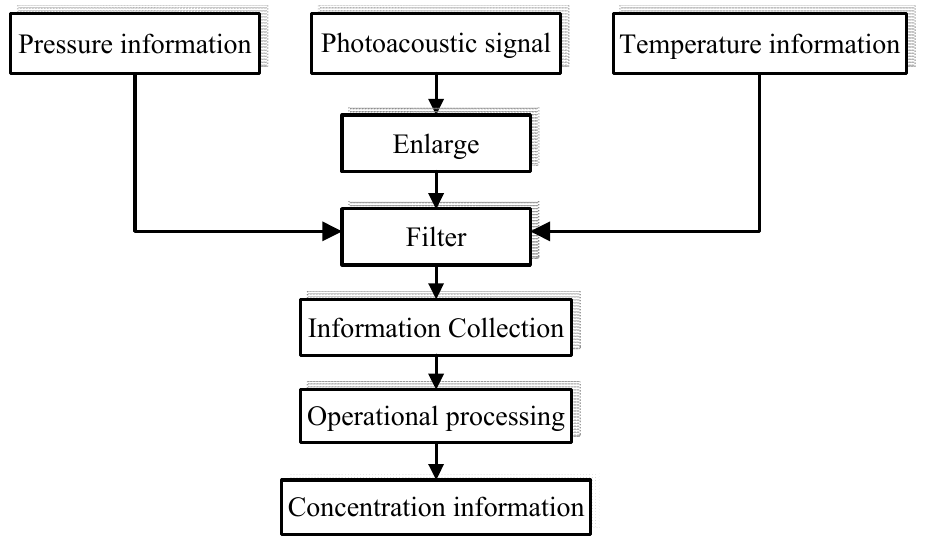
Figure 7. Flowchart of data processing system.